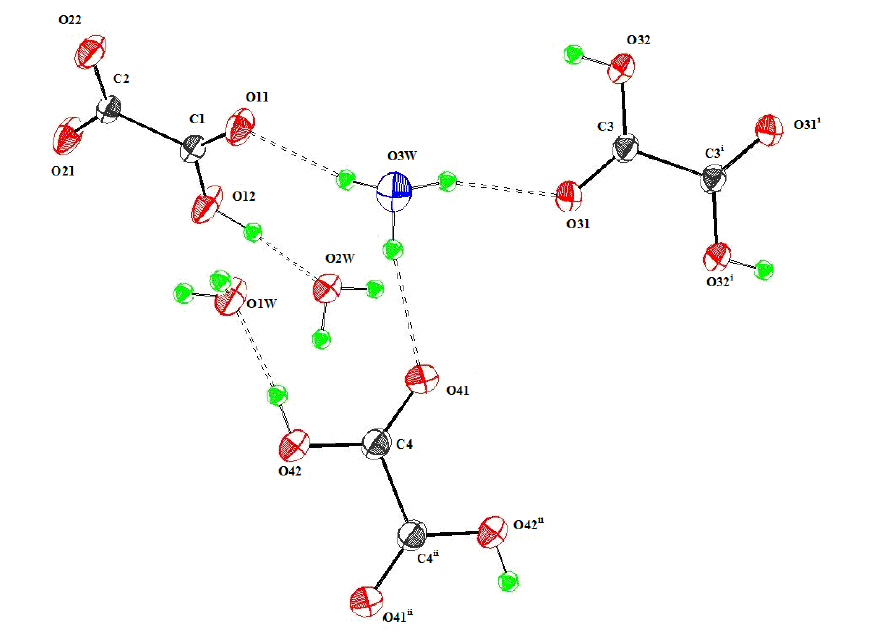
Figure 3. Molecular view of compound 2 . Displacement ellipsoids are drawn with 50%